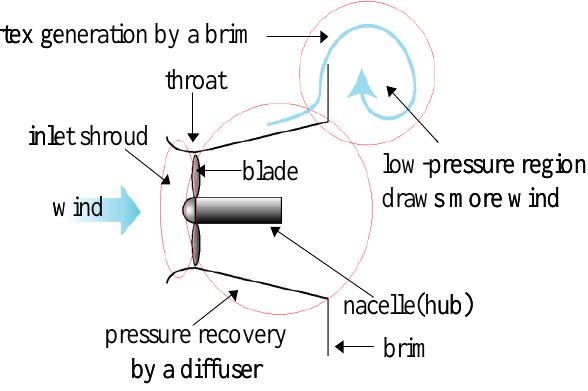
Figure 5. Flow around a wind turbine with brimmed diffuser